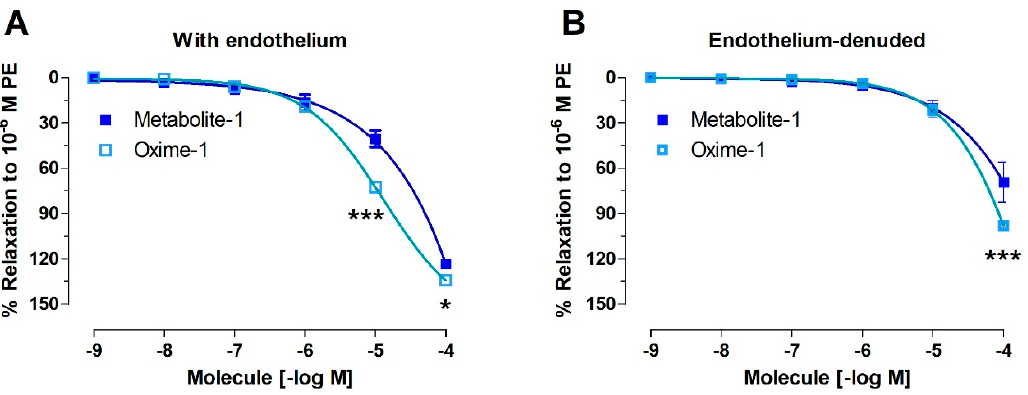
Figure 4. Metabolite–1 and oxime–1 cause relaxation in rat aorta via the endothelium-dependent pathway. Aortic rings were pre-contracted with 10 − 6 M PE, and cumulative concentrations of molecules (10 − 9 to 10 − 4 M) were added in bath. The protocol was repeated in intact rat aorta ( A ), and endothelium-denuded aorta ( B ). Data are presented as the average standard error of the mean (SEM) of 4–6 independent experiments. * p < 0.05; *** p < 0.001. Table 3. Relaxation effect of metabolite–1 or oxime–1 in pre-contracted aortic rings with PE: in presence, absence of endothelium, and pre-incubated with 10 − 4 M L-NAME. Molecule Endothelium Endothelium-Denuded L-NAME Metabolite–1 The values represent the half maximal effective concentration (EC 50 µ M) to different bioactive molecules. The values are mean ± standard error of the mean (SEM) of 4–6 independent experiments. Statistically